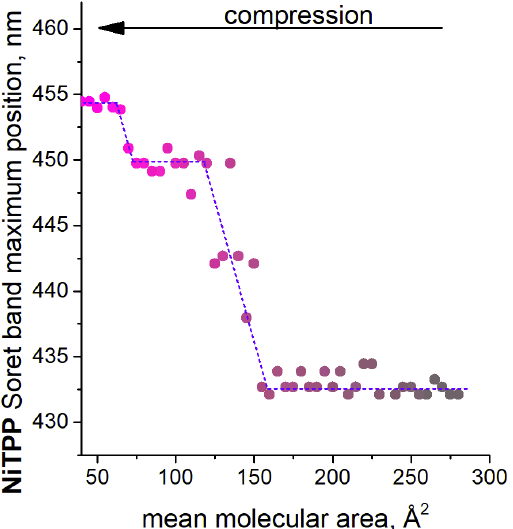
Figure 8. Dependence of the observed Soret band dominant wavelength on mean molecular area value of the mixed NiTPP × CRPcRu(pyz) 2 Langmuir monolayer upon its lateral compression. The arrow denotes the direction of the compression (rapprochement of the molecules in the monolayer) for clarity.